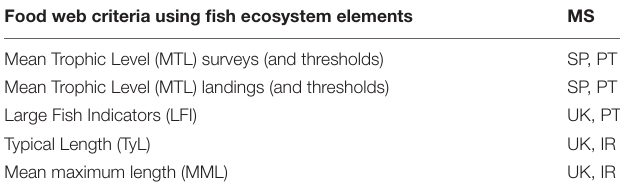
TABLE 1 | Food web criteria selected by each MS concerning fish taxonomic elements. Food web criteria using fish ecosystem